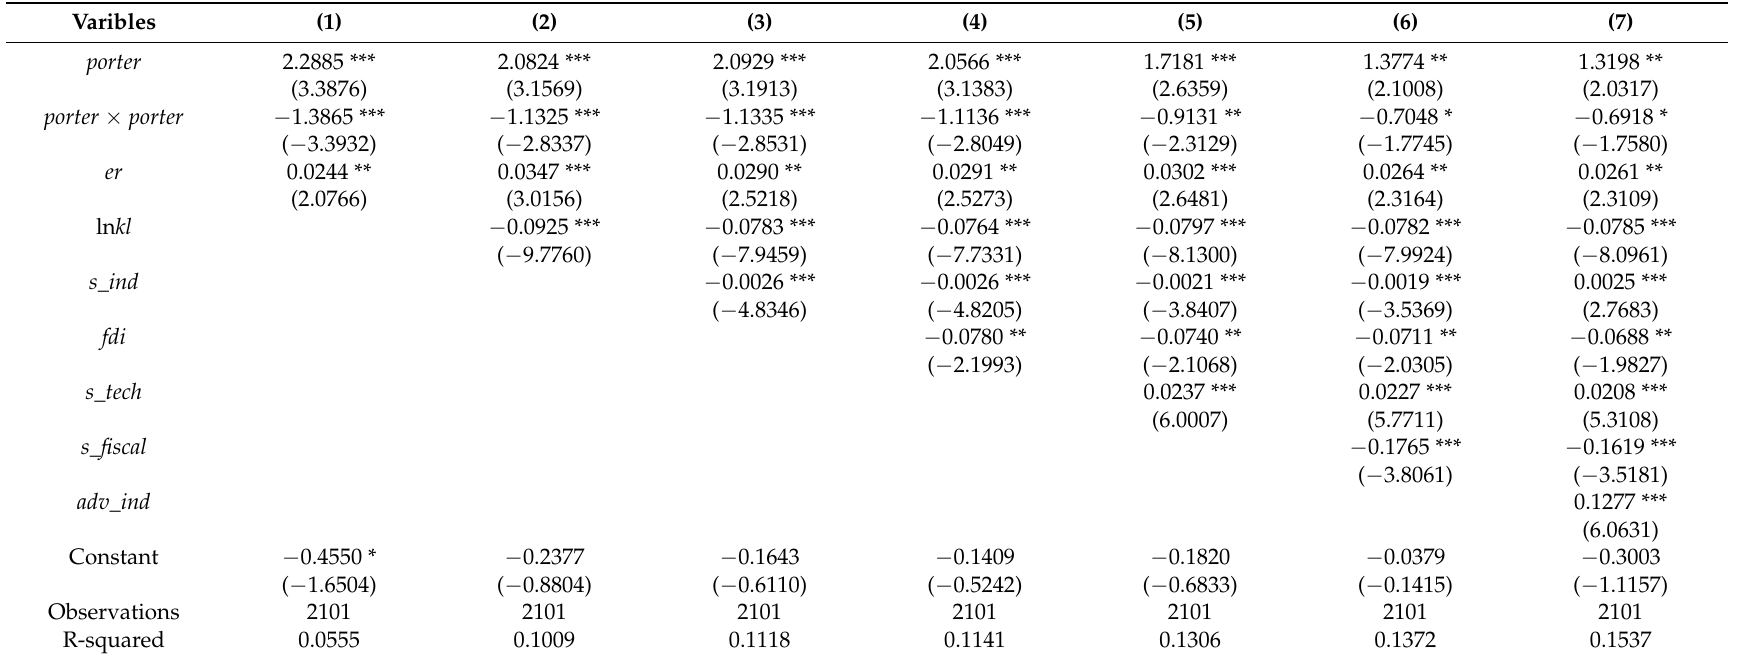
Table 6. Estimation results of the Porter externality and urban